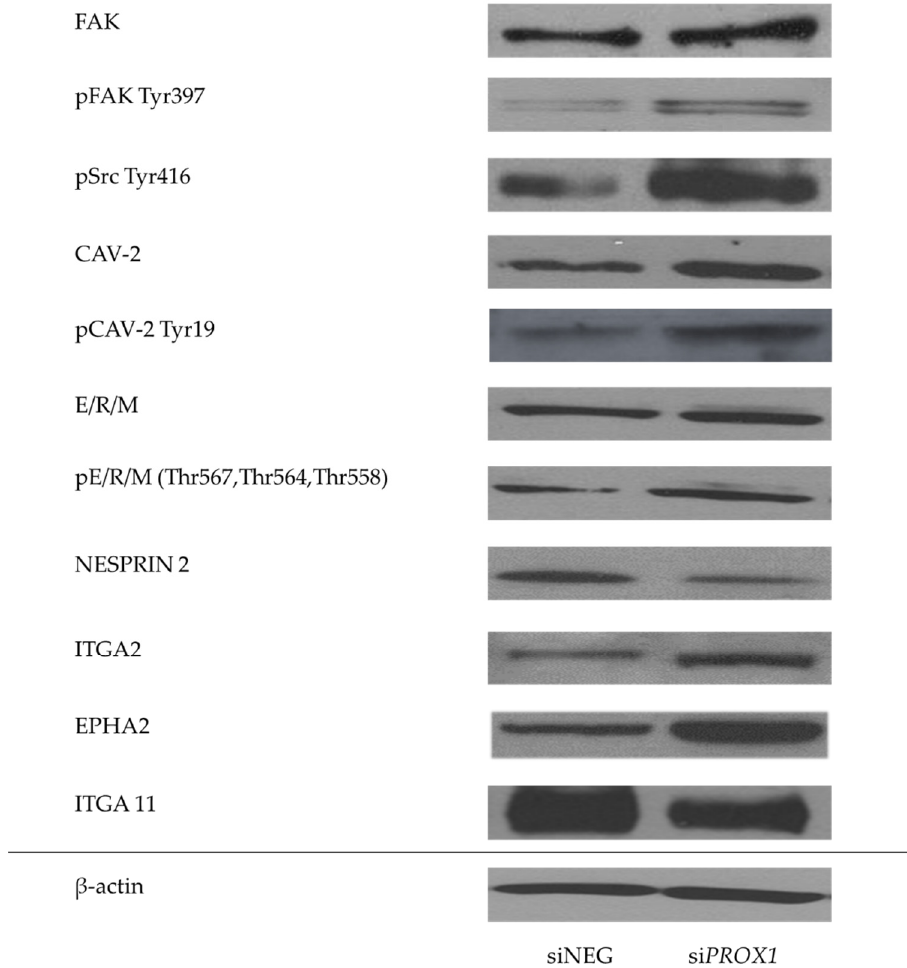
Figure 6. The evaluation of selected genes associated with organization of the cytoskeleton, migration and cell adhesion with significantly deregulated mRNA expression due to PROX1 knock-down. The expression levels of proteins (FAK kinase protein, caveolin-2, ezrin, radixin and moesin, nesprin-2, integrin alpha 2, ephrin type-A receptor 2, integrin alpha 11) and phospho-proteins (phosphorylation of FAK at Tyr(tyrosine)-397, phosphorylation of proto-oncogene tyrosine-protein kinase Src at Tyr-416, phosphorylation of caveolin-2 at Tyr-19 and phosphorylation of ezrin at Thr(threonine)-567, radixin at Thr-564 and moesin at Thr-558) in CGTH cells transfected with si PROX1 and siNEG RNA, as determined by Western blotting. The whole cell lysates were resolved using SDS-PAGE (sodium dodecyl sulphate-polyacrylamide gel electrophoresis), transferred on nitrocellulose membranes, then incubated with primary and relevant secondary antibodies and visualized with chemiluminescence detection substrate. β -actin was used as a loading control. Presented blots are representative of three independent experiments.